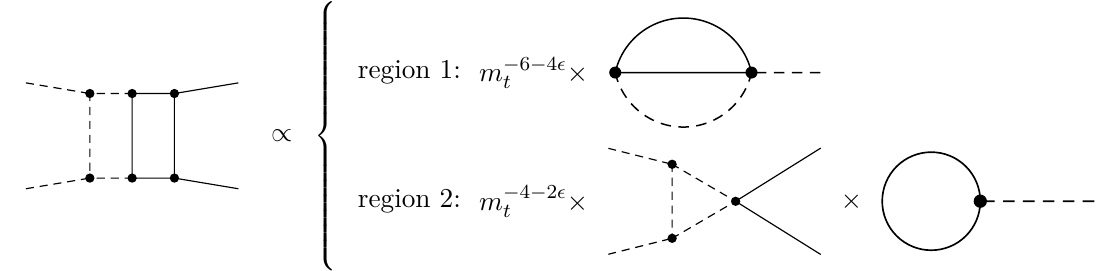
Figure 2. A typical master integral and its leading regions. Solid and dashed lines describe massive and massless particles respectively. All internal massive particles have masses equal to m t , while all external massive particles have masses equal to m Z .